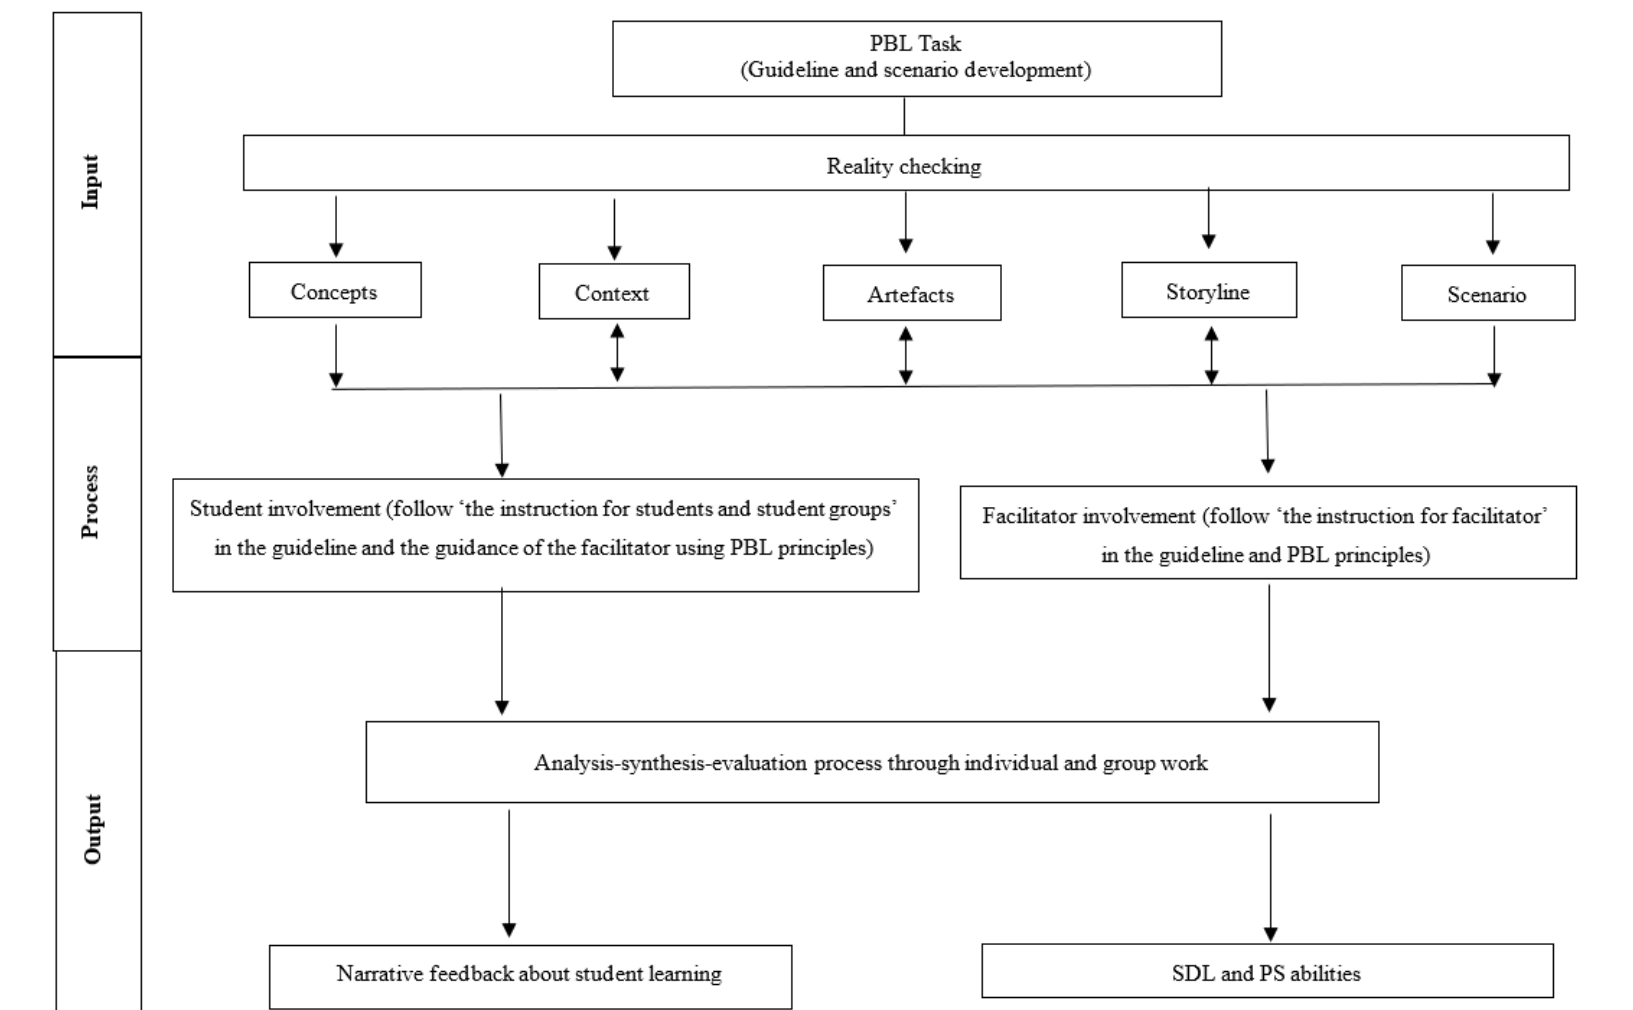
Figure 1. Conceptual framework of input-process-output (IPO) (Albion and Gibson 1998).